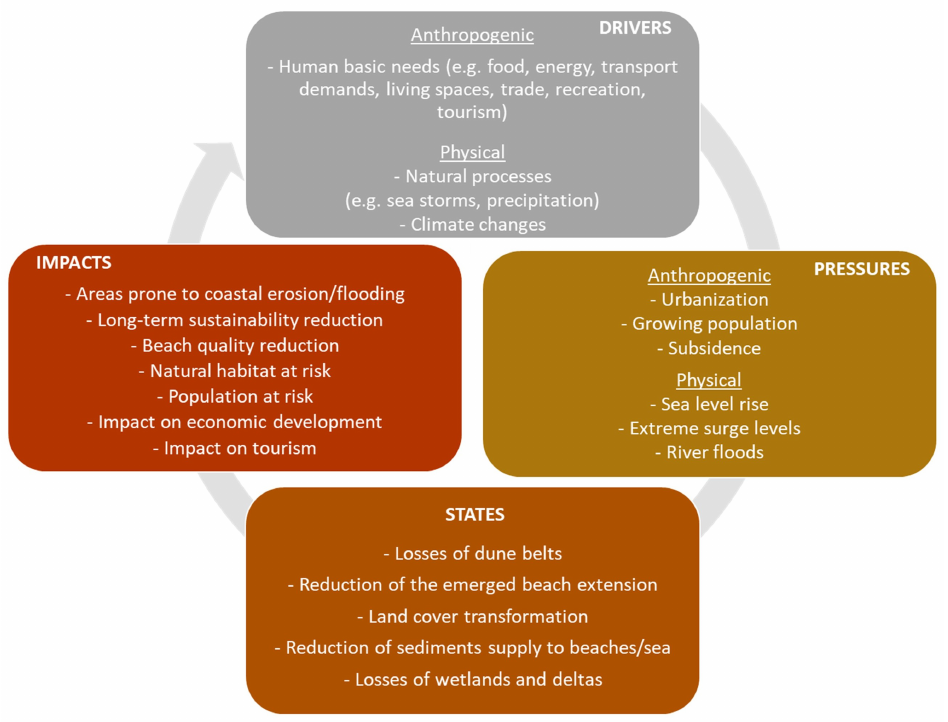
Figure 2. Risk profile—DPSIR Path of Effects